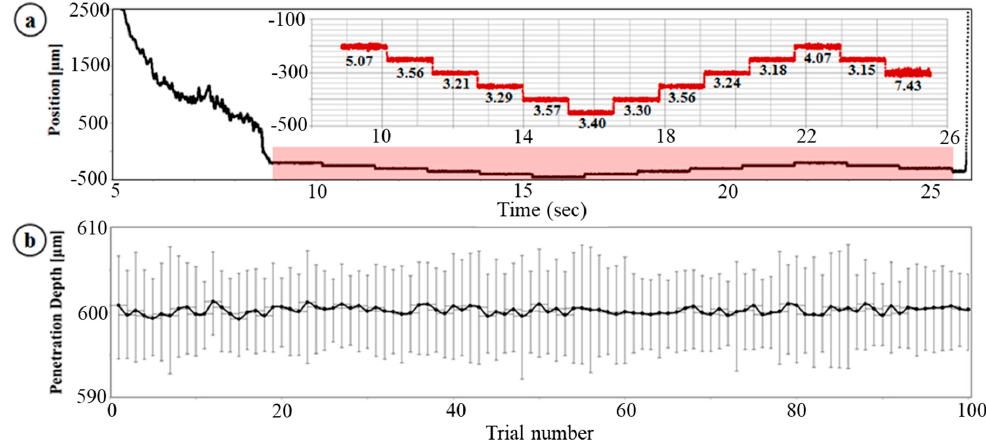
Figure 6. ( a ) Dynamic insertion test under the condition that it has interaction between needle tip and sample material. The upper inserted graph is a partial magnified graph of area in red square in lower entire graph. ( b ) The average deviation error of 100 injections with error bar consisting a positive and negative RMSE.